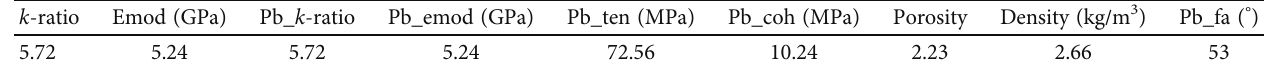
Table 2: Mesoparameters of limestone.